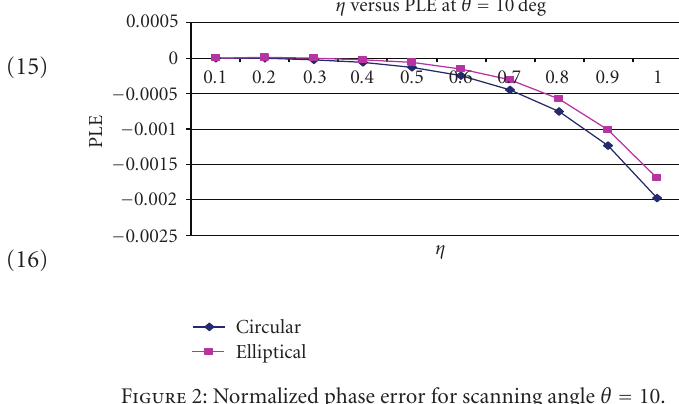
Figure 2: Normalized phase error for scanning angle θ = 10.